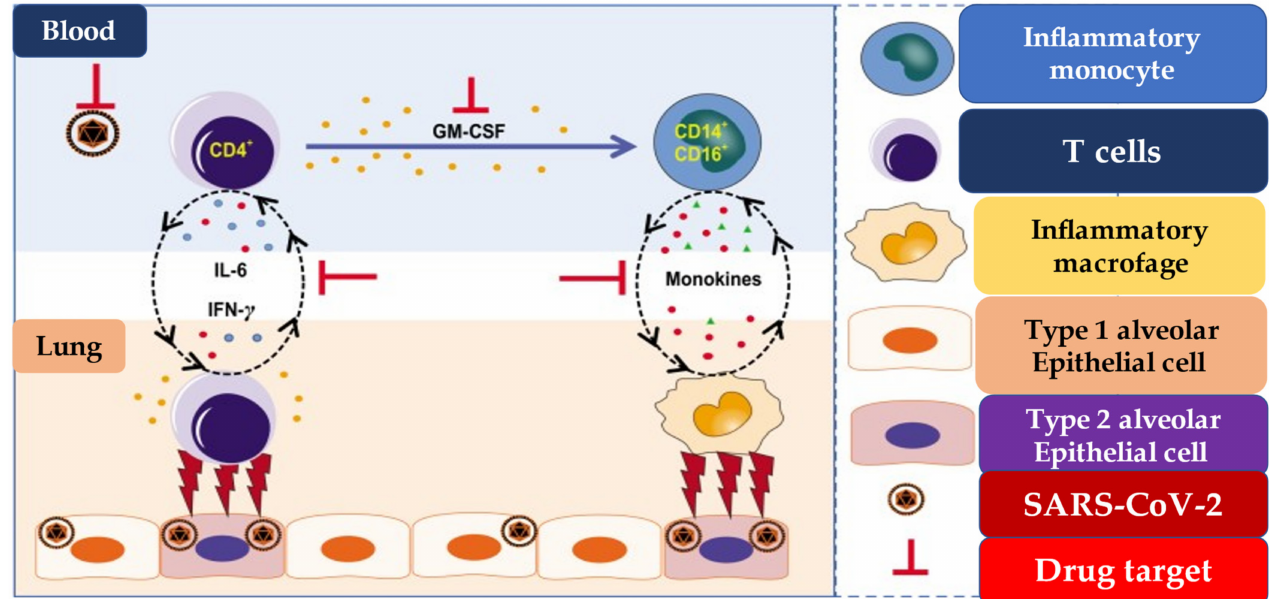
Figure 3. Pathogenic Th1 cells and inflammatory monocytes in severe COVID-19. Pathogenic CD4 + Th1 (GM-CSF + IFN- γ + ) cells were rapidly activated to produce GM-CSF and other inflammatory cytokines to form a cascade signature of inflammatory monocytes (CD14 + CD16 + with high expression of IL-6) and their progeny. These activated immune cells may enter the pulmonary circulation in large numbers and played an immune-damaging role in severe-pulmonary-syndrome patients. The monoclonal antibodies that target the GM-CSF or interleukin-6 receptor may potentially prevent or curb immunopathology caused by COVID-19. Abbreviations; GM-CSF, granulocyte-macrophage colony stimulating factor; IL, interleukine; IFN- γ , interf é ron gamma; SARS-CoV-2: severe acute respiratory